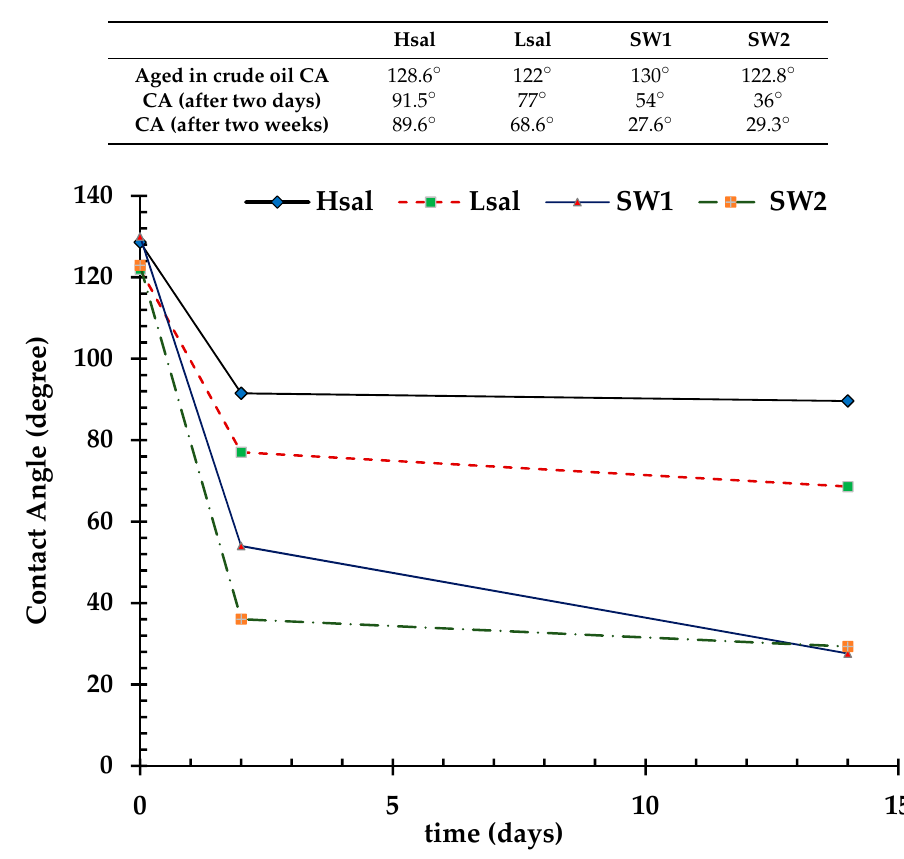
Figure 8. Change in CA after treatment of Case 4 (oil wet) calcite surface by different brines for two days and two weeks.